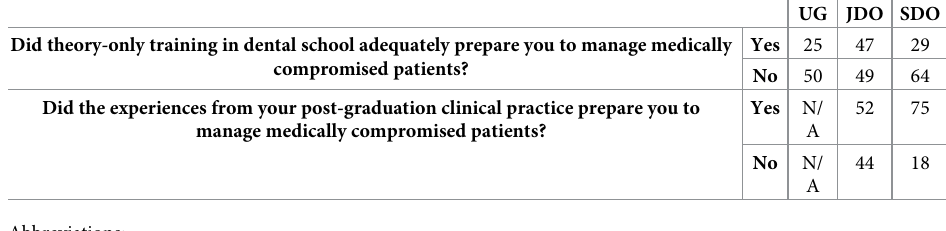
Table 5. Perspective on dental school and post-graduation